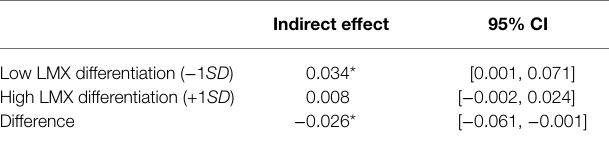
TABLE 4 | Conditional indirect effects of ethical leadership on deviant behavior via psychological empowerment at low and high levels of LMX differentiation.